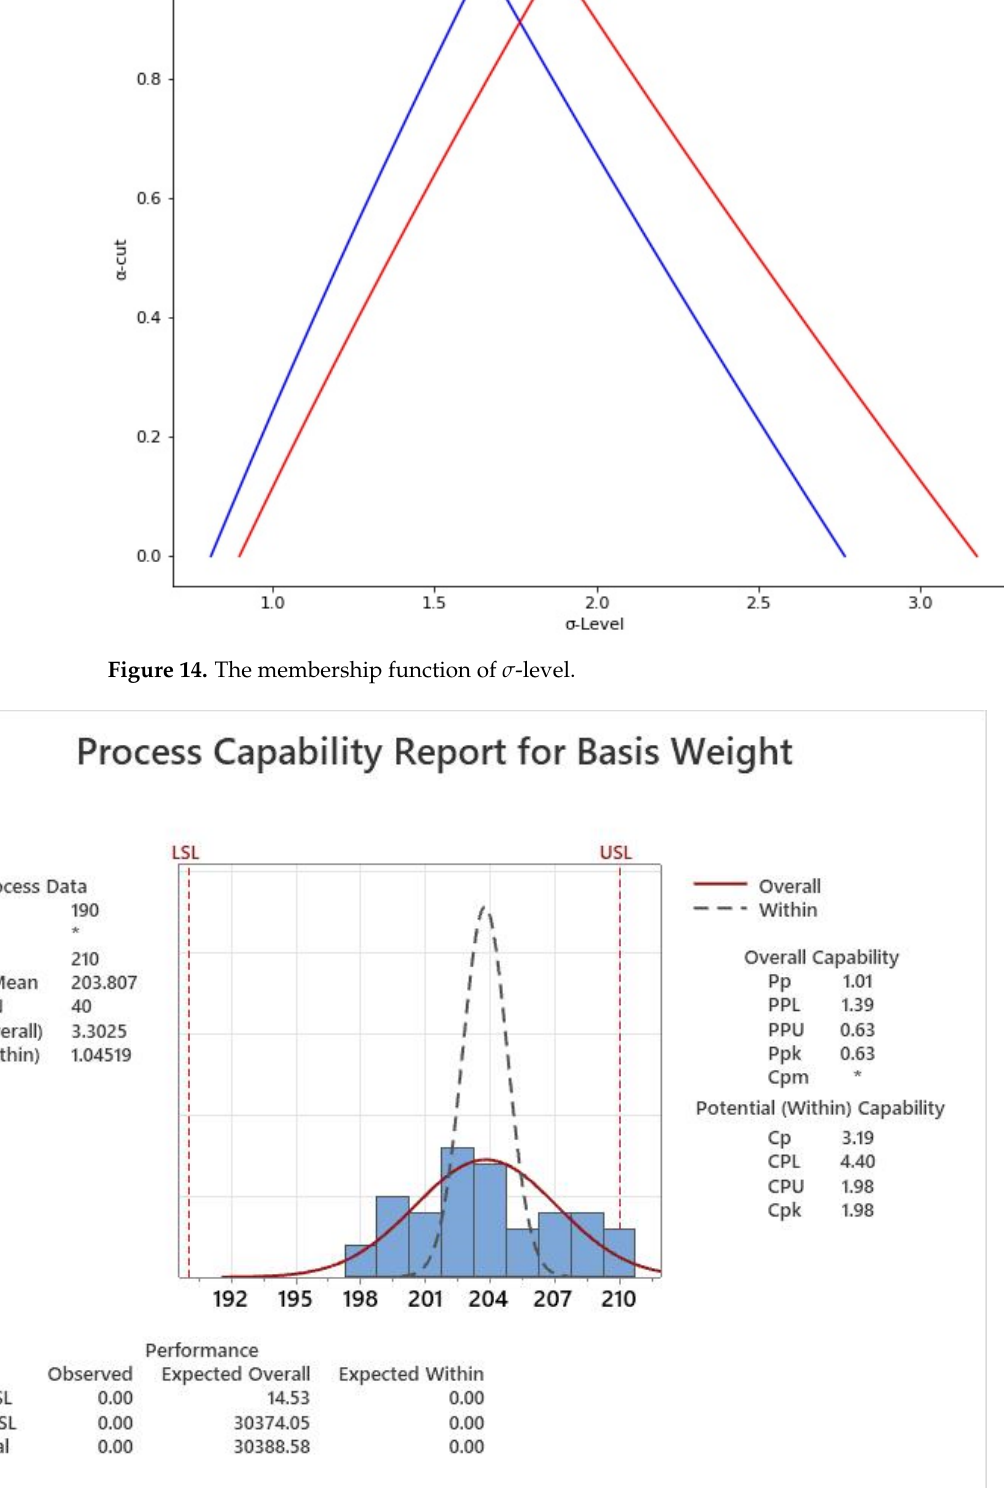
Figure 15. Traditional process capability indices. Since no target value was defined, the Cpm index cannot be calculated (the result is shown as *).